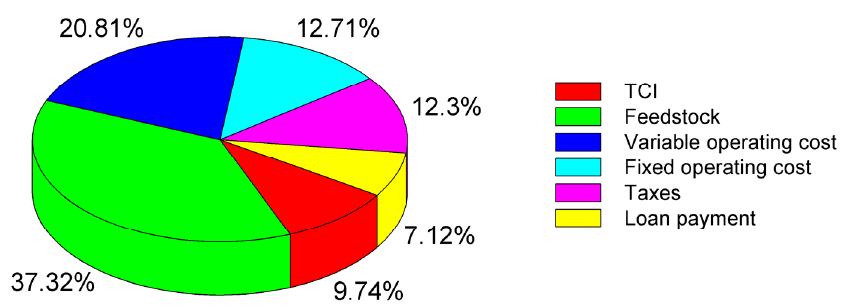
Figure 8. Cost breakdown by composition in scenario NREL-CN_1.